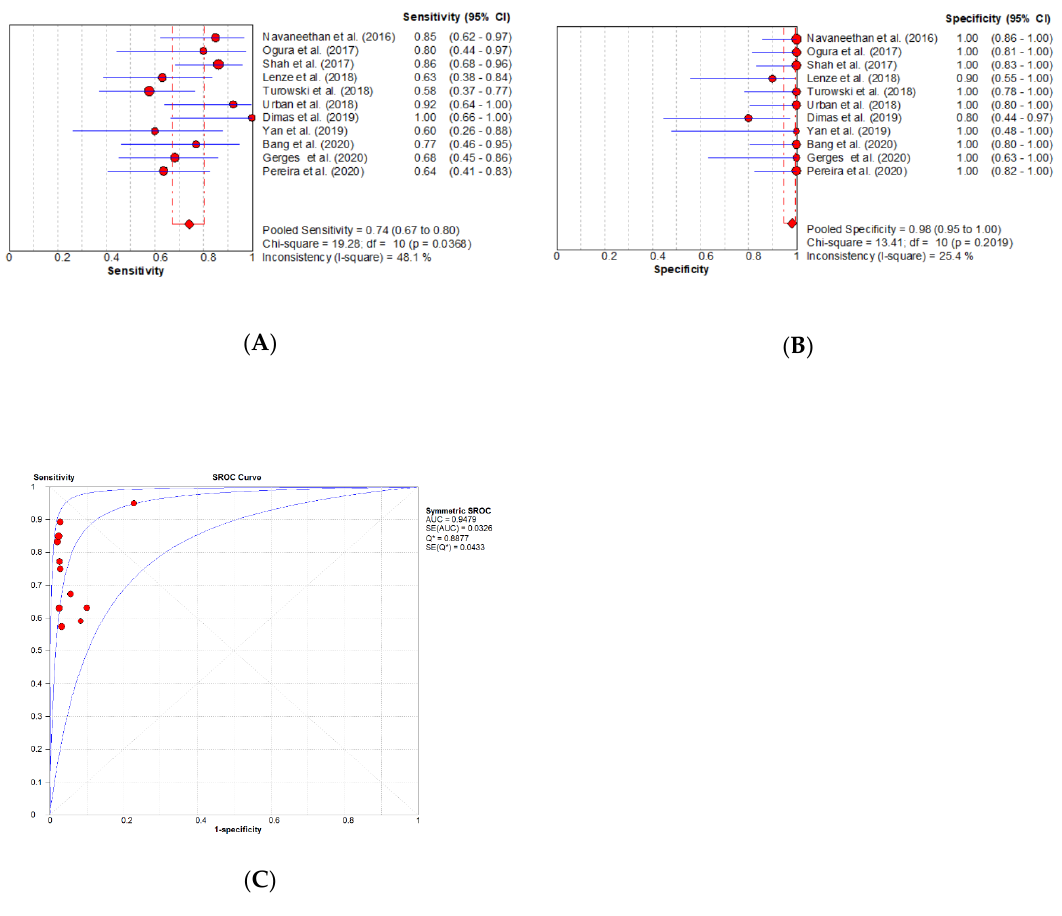
Figure 3. The forest plot of studies that reported the diagnostic yield of digital single-operator cholangioscopy (DSOC) by SB. ( A ) The pooled sensitivity for indeterminate biliary strictures